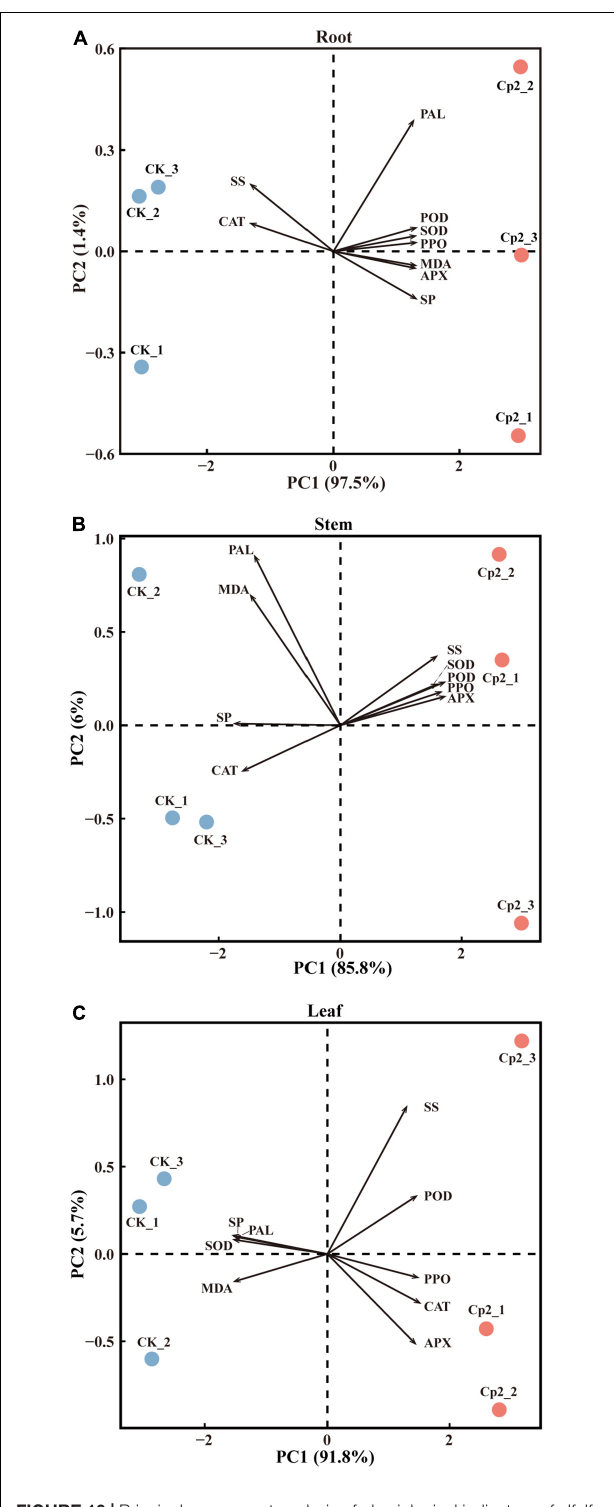
FIGURE 10 | Principal component analysis of physiological indicators of alfalfa inoculated with E. persicina Cp2. (A–C) Results of physiological indicators of leaf, stem, and root. The percent total variance is shown for PC1 and PC2 in parenthesis in the axis. PCA, principal component analysis; PC1, principal component 1; PC2, principal component